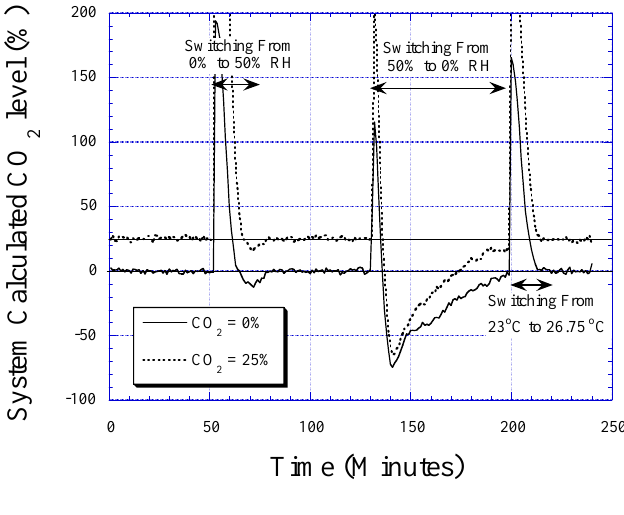
Figure 11. CO concentration determined using measured data as corrected by Eq. 8 with 2 calibration parameters of Table 1; measurements are taken with CO and 25%. Outside of the transient region, upon reaching steady state measured results are within ± 3%. Since the different sensors have different response rates large errors occur when humidity and temperature change, an effect dominated by the slow desorption of moisture from the